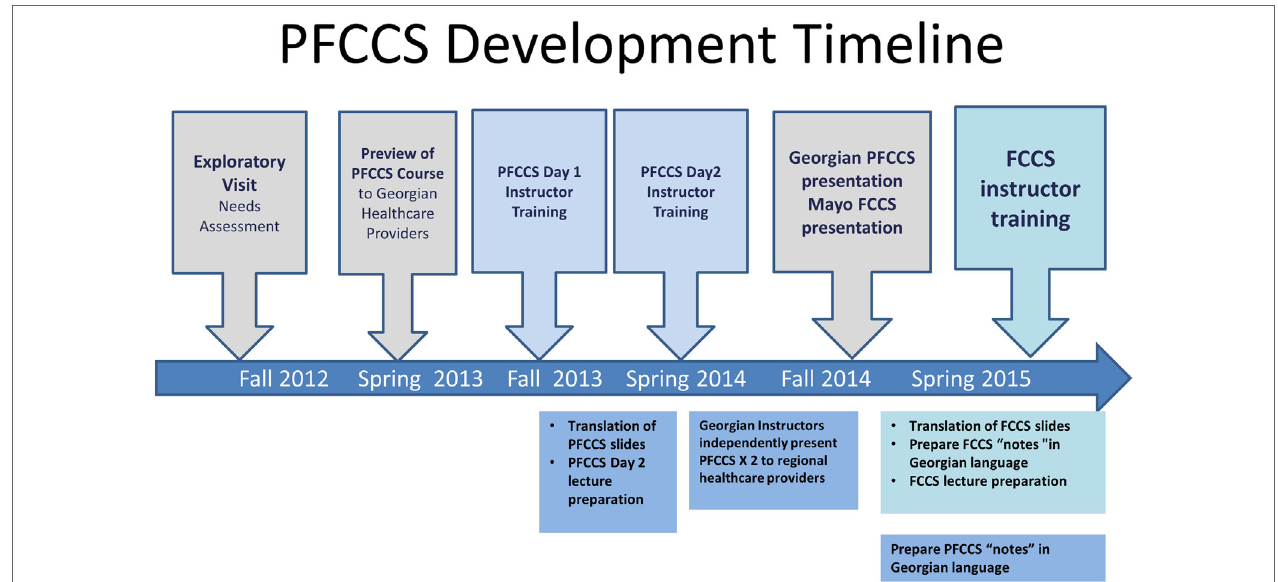
Figure 2 | The PFCCS principles of rapid assessment emphasized during the